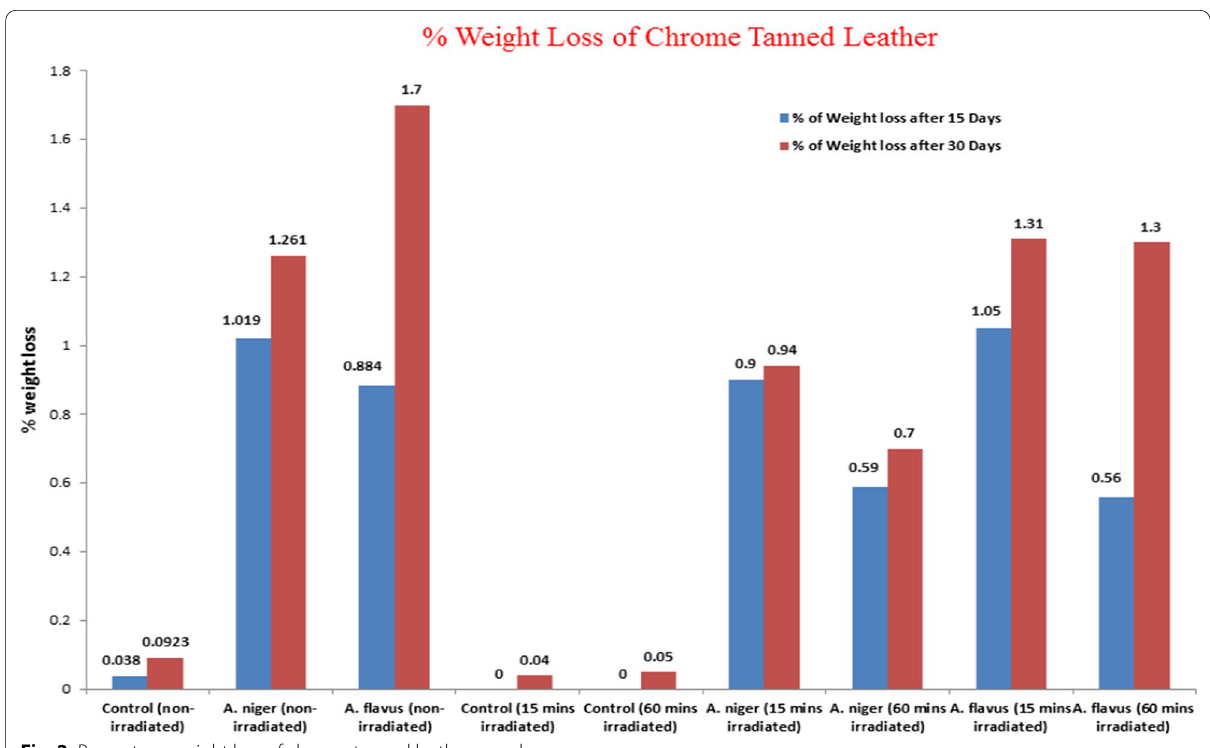
Fig. 2 Percentage weight loss of chrome tanned leather